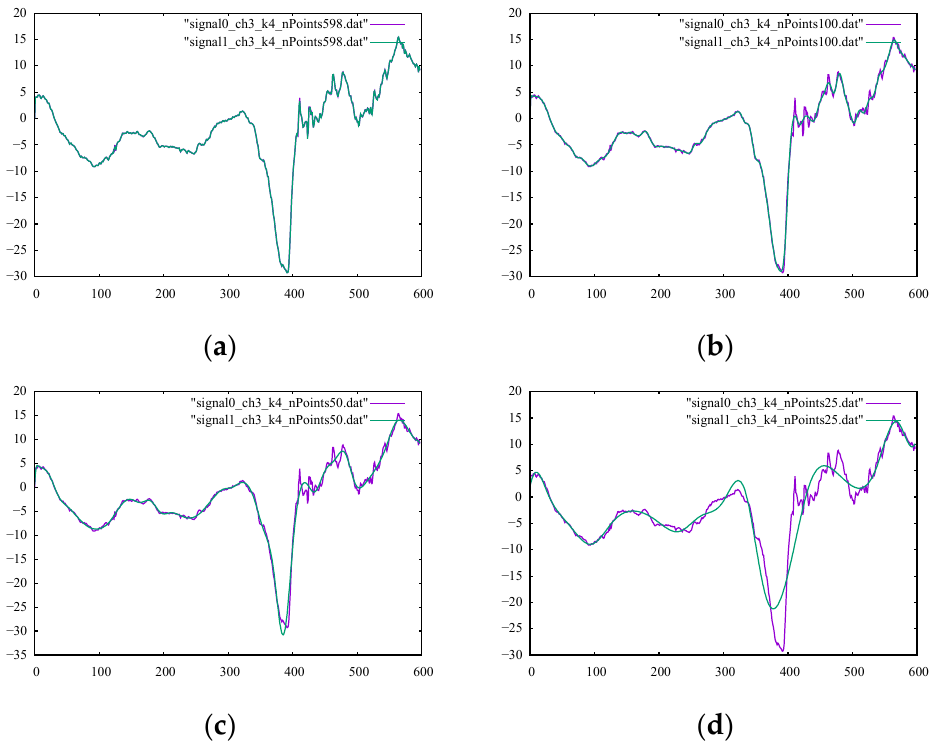
Figure 9. Original noisy motion signal from channel 3 of the root-joint of the kicking character versus the smoothed signal via B-spline smoothing using ( a ) 598, ( b ) 100, ( c ) 50, and ( d ) 25 control points. Next, the Kalman filter was utilized to process the signals of the kicking character, and the values of the SM1 and SM2 measures are given in their corresponding columns in Tables 4 and 5, respectively. Moreover, their corresponding percentages of relative difference are listed in Tables 6 and 7. By comparing the smoothness metrics in Table 7 with the corresponding values reported for other the methods studied, the Kalman filter provided fewer smooth outputs in terms of the SM2 parameter. The SM1 percentage of relative difference values provided in Table 6 were also too high. The output signals, as well as their original signals, using various Kalman filter parameters E mea are shown in Figures 10 and 11. Upon inspection of the filtered signals, we confirmed that only the outputs using E mea = 0.005 properly reproduced the desired filtering. Moreover, the filtered signals occasionally showed noisy movements because of instantaneous loops of estimated error and gain.